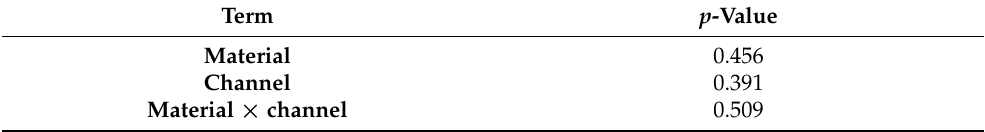
Table 4. Test of fixed effects in the mixed multilevel model using EMG as a